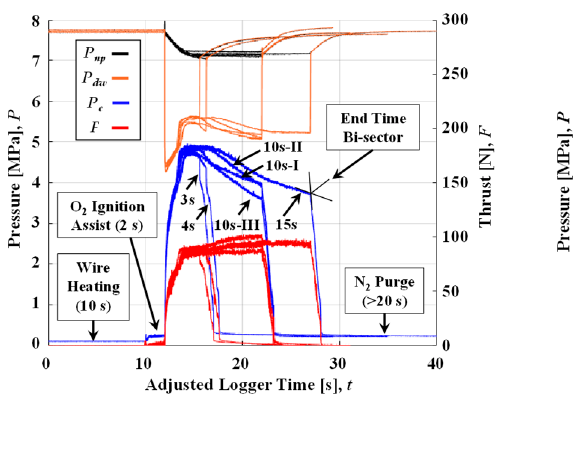
Figure 7. Unprocessed static firing test data of all tests; ( a ) the first 40 s of the firing sequence, ( b ) expanded graph of the first 4 s of ignition and start-up transients.